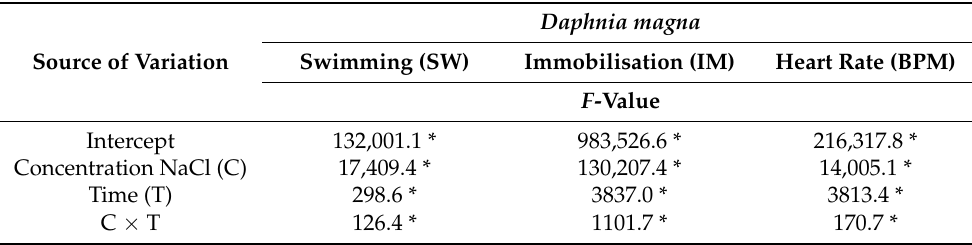
Table 5. Analysis of variance (ANOVA) for morphological and biochemical features of crustaceans Daphnia magna exposed to sodium chloride (NaCl).